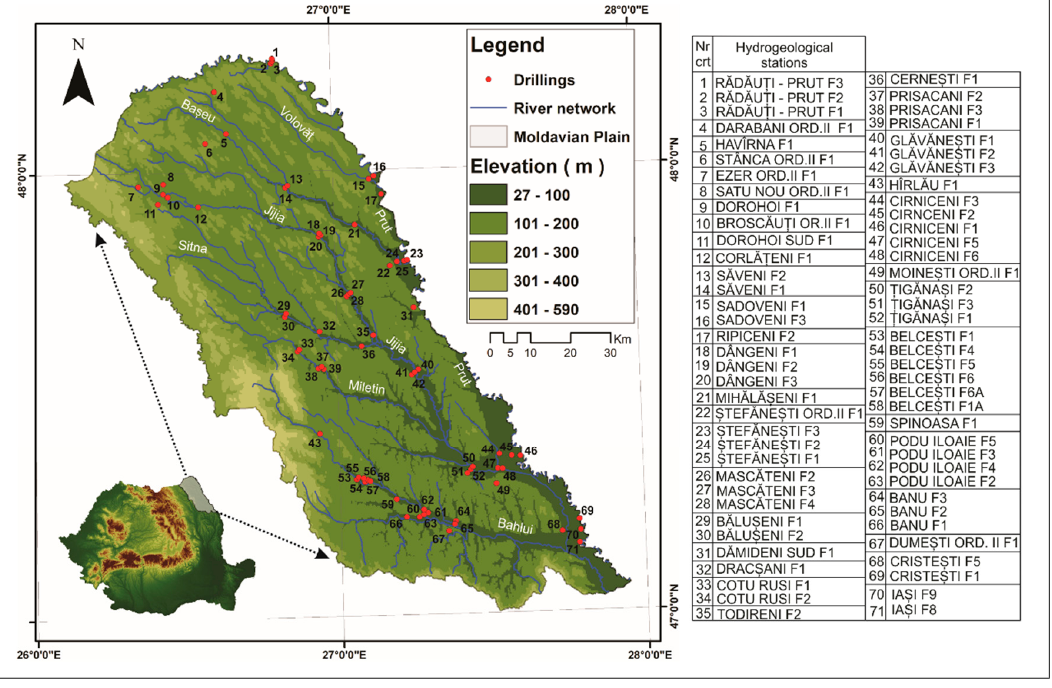
Figure 1. The distribution of wells in north-eastern part of Romania.